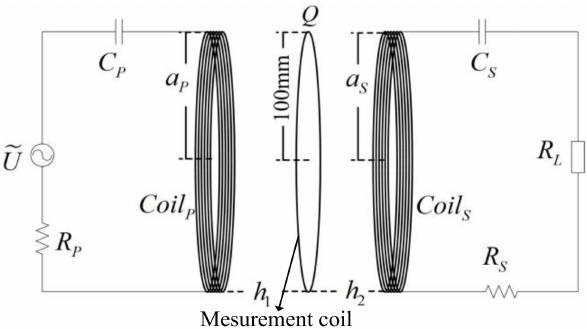
Figure 11. Experimental configuration.